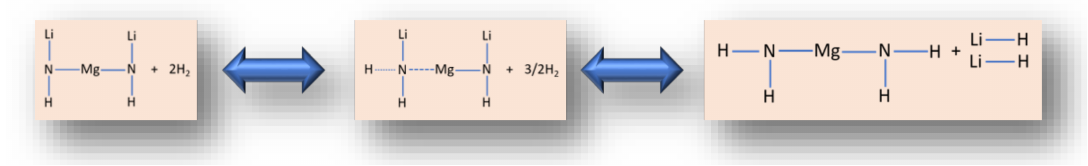
Figure 4. Proposed mechanism in the hydrogen sorption reaction of the Li 2 Mg(NH) 2 system